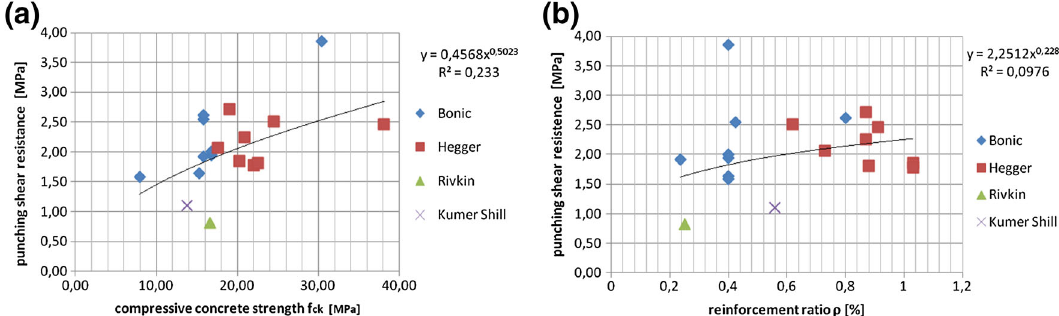
Fig. 14 Dependence of the punching resistance v n of the: a concrete compressive strength ( f ck ); b reinforcement ratio ( q l ).